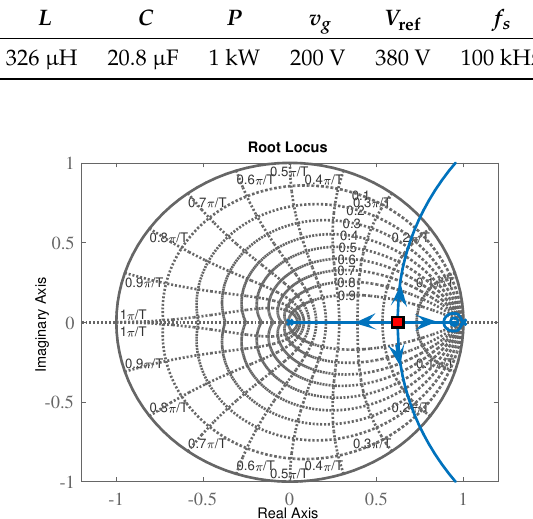
Figure 11. Root locus of the system. At the double pole position z ba the real axis, the gain K p 0.82 leading theoretically to damping coefficient ζ = 1 and null ≈